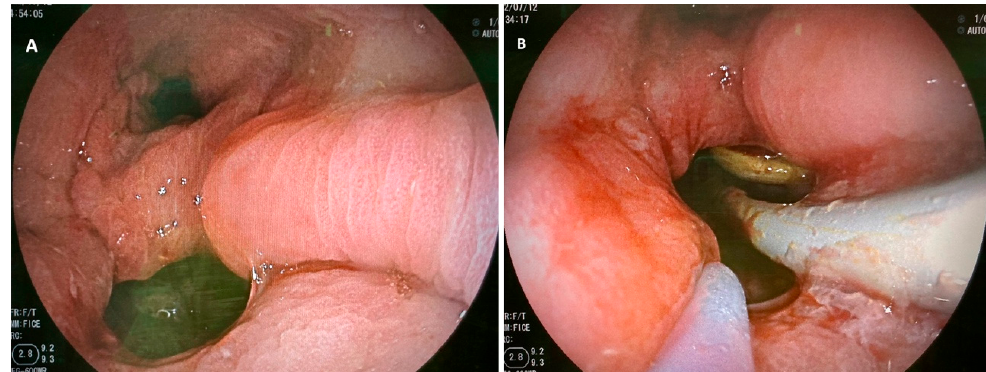
Figure 2. ( A , B ): Stapler line dehiscence after sleeve gastrectomy: ( A ) orifice and gastric inlet, ( B ) pigtail placement through the defect into the associated cavity.